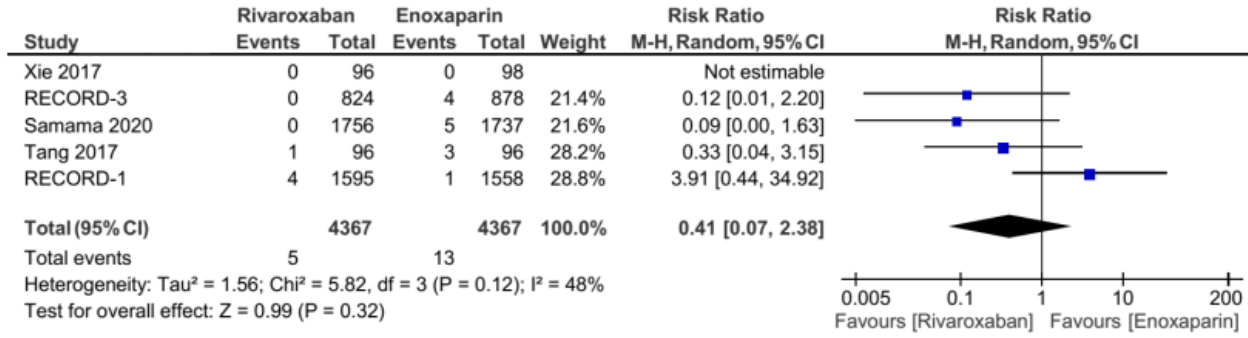
Figure 5. Incidence of fatal and nonfatal PE [5,7,12 – 14].